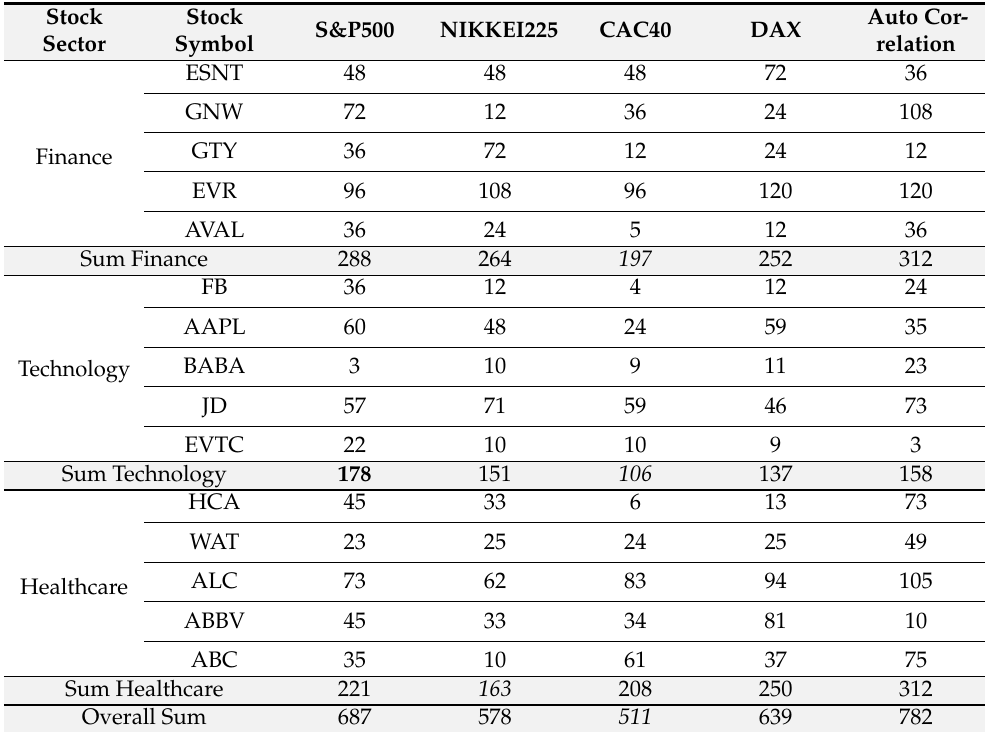
Table 12. The count of the total number of features selected per stock. Stock